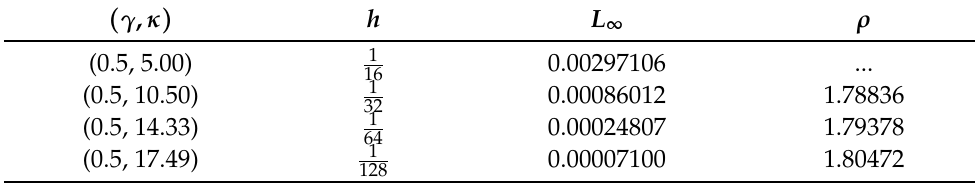
Table 9. The L ∞ errors and ρ of Example 2 when K =